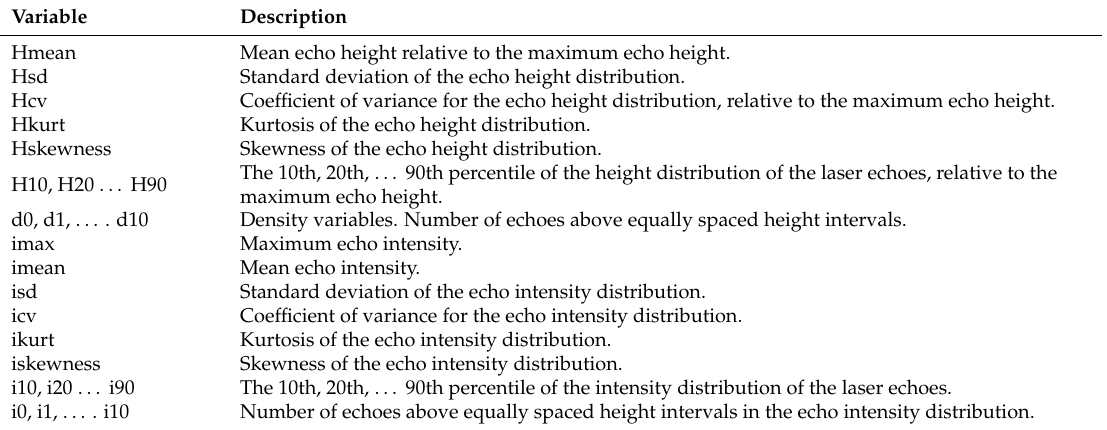
Table 3. Variables derived from the airborne laser scanner (ALS)